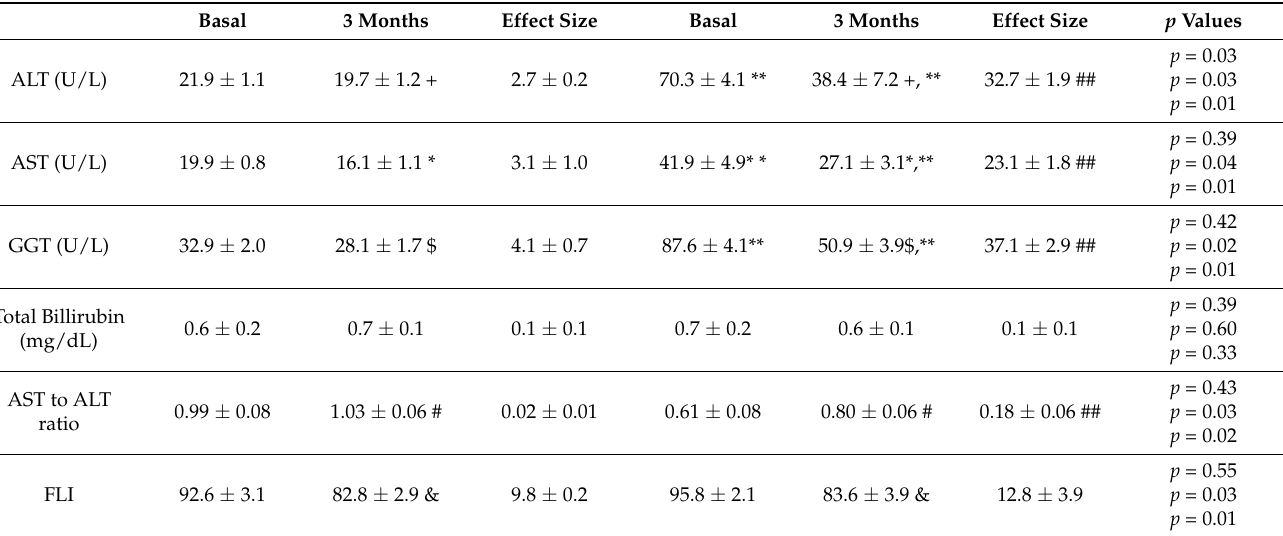
Table 6. Liver parameters in different groups (mean ± standard deviation) at basal time and after 3 months of